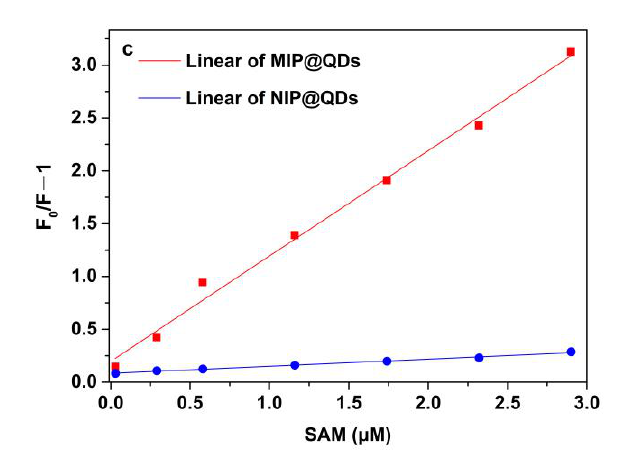
Figure 7. Fluorescence emission spectra of a MIP@QDs and b NIP@QDs with increasing concentra- tions of SAM; c the linear calibration of the fluorescence-quenching degree versus SAM concentra- tion of MIP@QDs and NIP@QDs. Experimental conditions: SAM (0, 0.29, 2.9, 5.8, 1.16,1.74, 2.32, 2.90 μM), pH = 8.5, and room temperature.